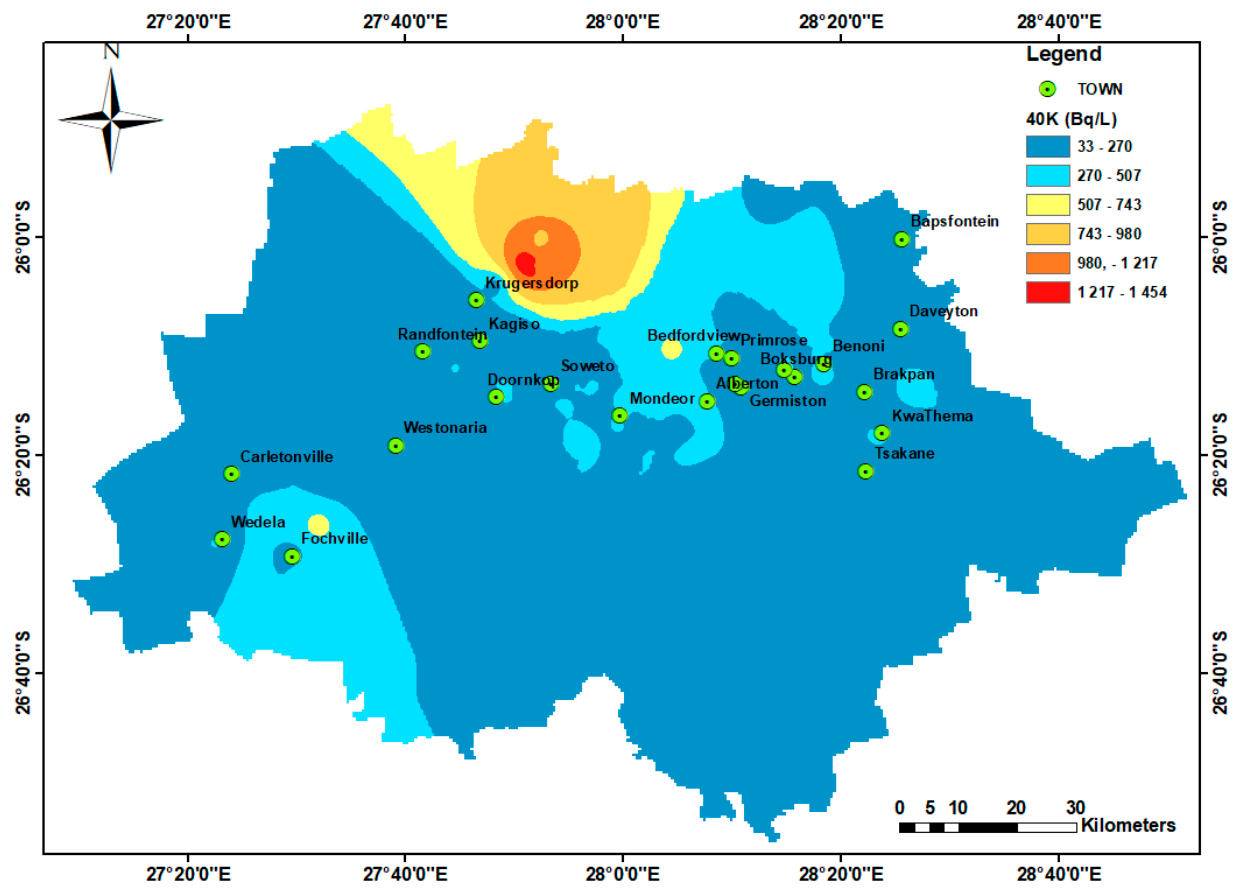
Figure 10. Spatial activity distribution map of 40 K (Bq/kg).